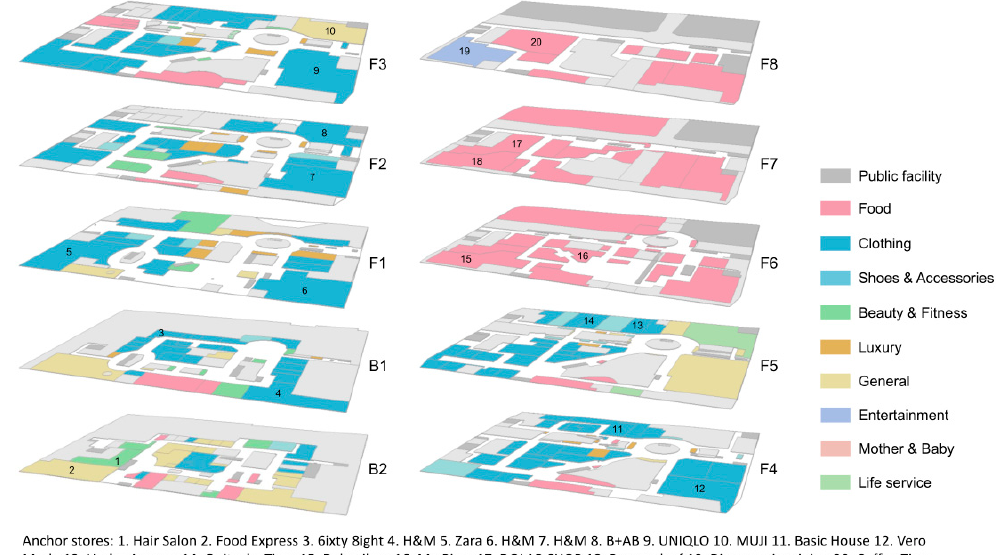
Figure 2. Store classes and layout of DYC (F1-F7 means Floor 1 to 7, and B1 and B2 means Basement level 1 and 2).